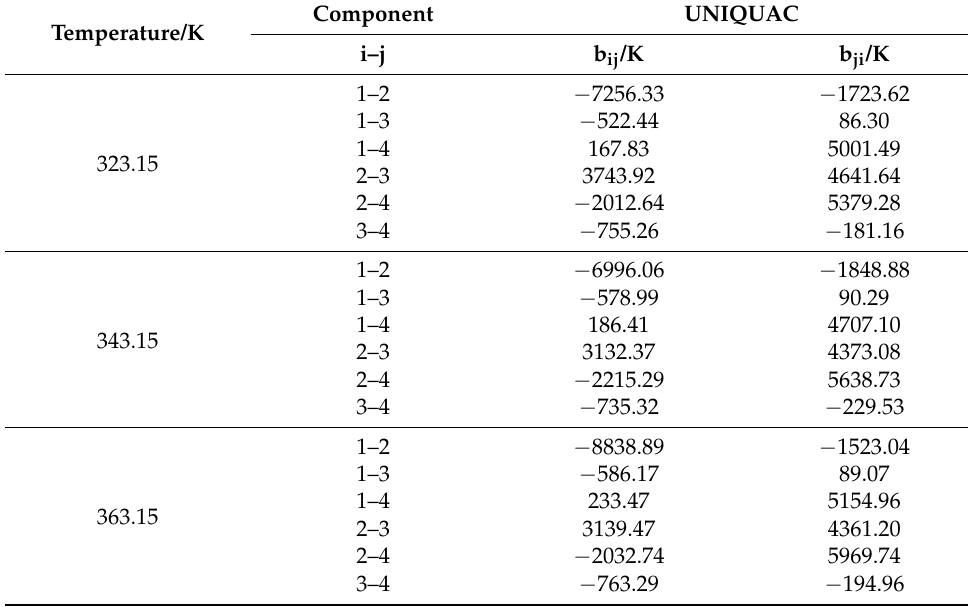
Table 4. UNIQUAC model parameters for FA (1)-OF (2)-OC (3)-water (4) system.